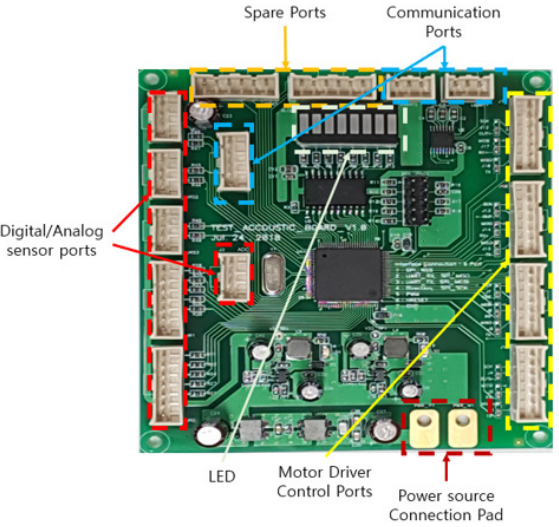
Figure 4. Configuration of the onboard robotic platform’s main